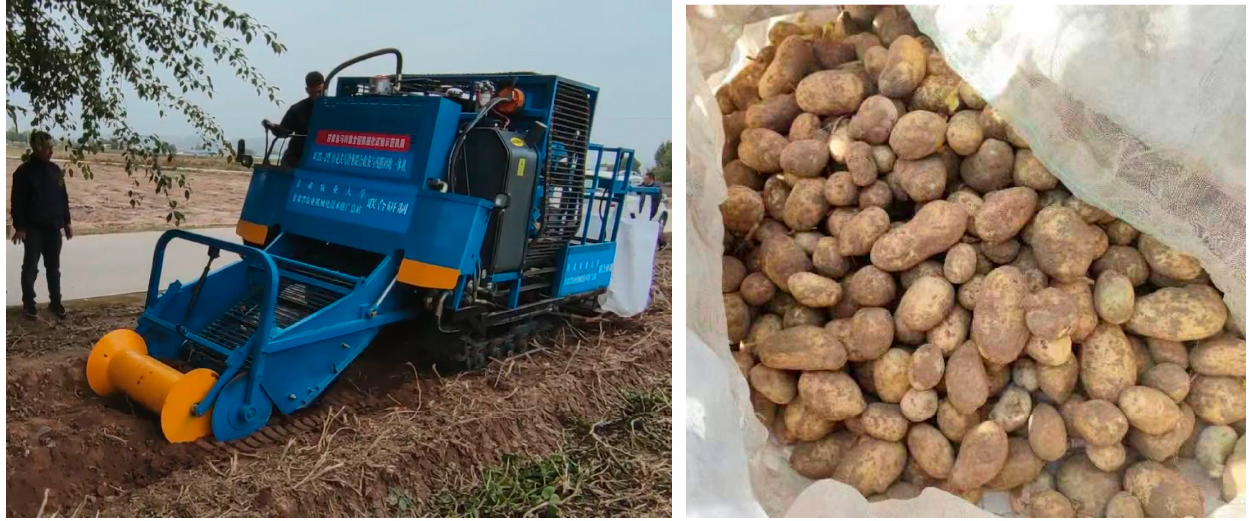
Figure 16. Field test showing the digging and lifting device of the self-propelled machine for combined potato harvesting and residual plastic film retrieval and a bag of harvested potatoes.